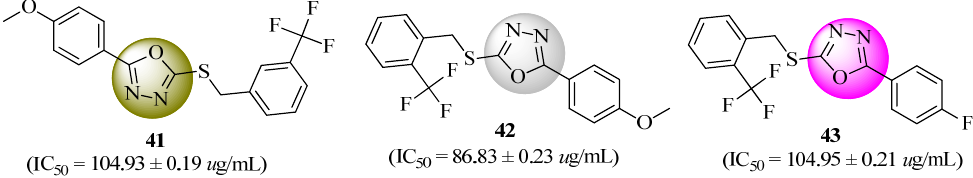
Figure 22. Inhibitors of alfa-amylase activity based on 1,3,4-oxadiazole derivatives.